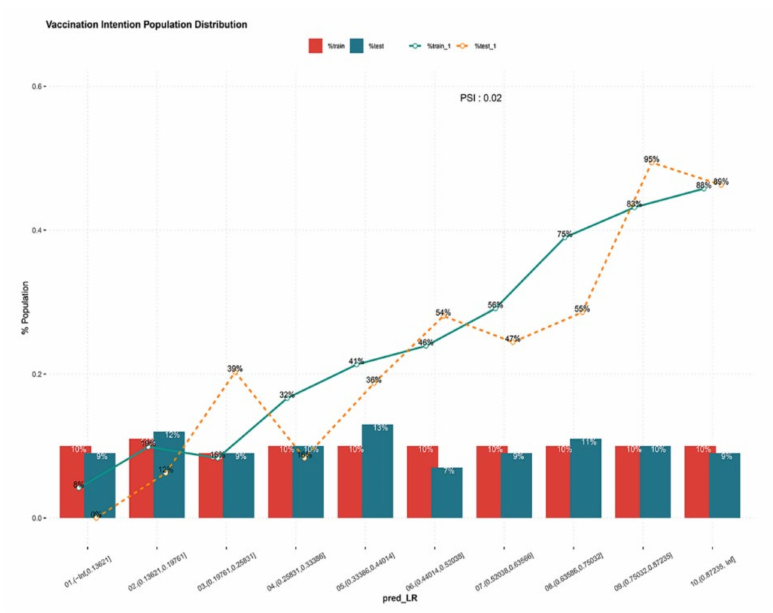
Figure 6. The PSI in the training set and test set. The PSI of the vaccination intention prediction model. The green line represents the performance of the model in the test set, and the orange line represents the performance of the model in the training